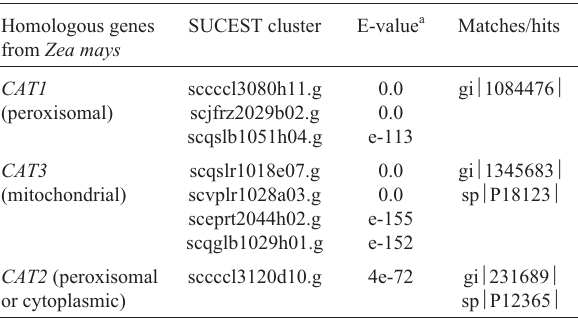
Table VII - Catalase homologues in